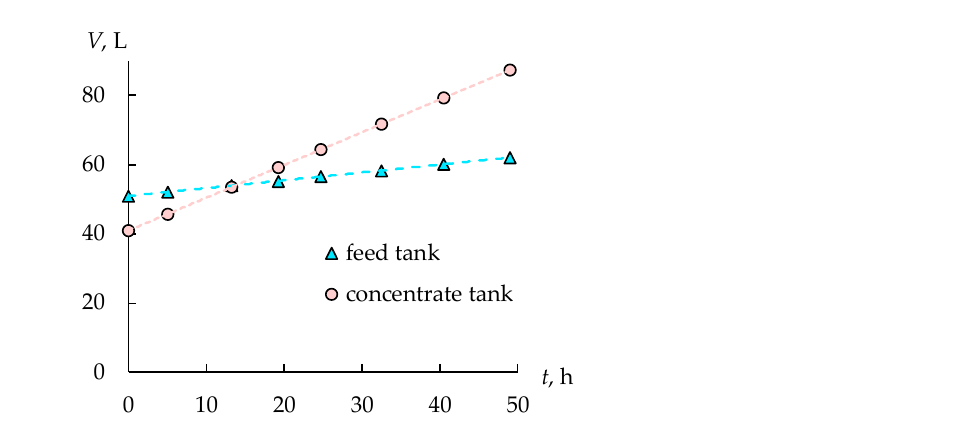
Figure 9. The solution volume in the concentrate and feed tanks during the second stage.